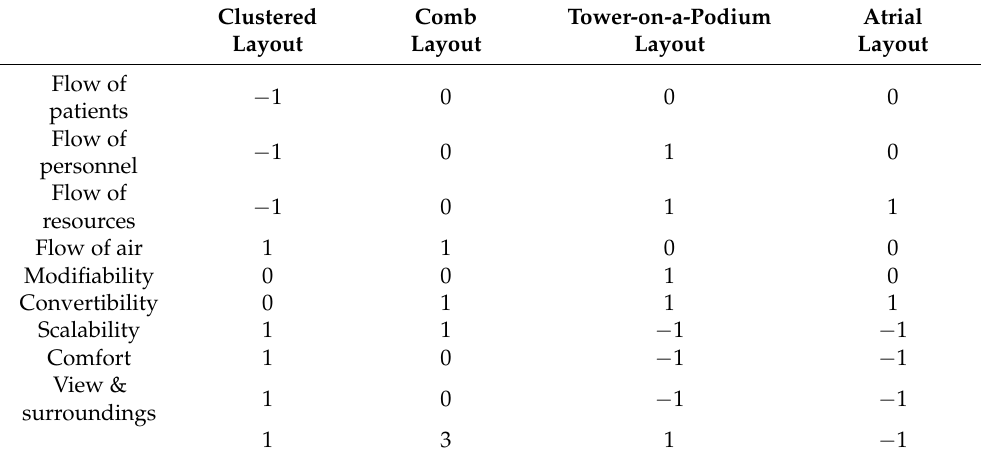
Clustered Layout